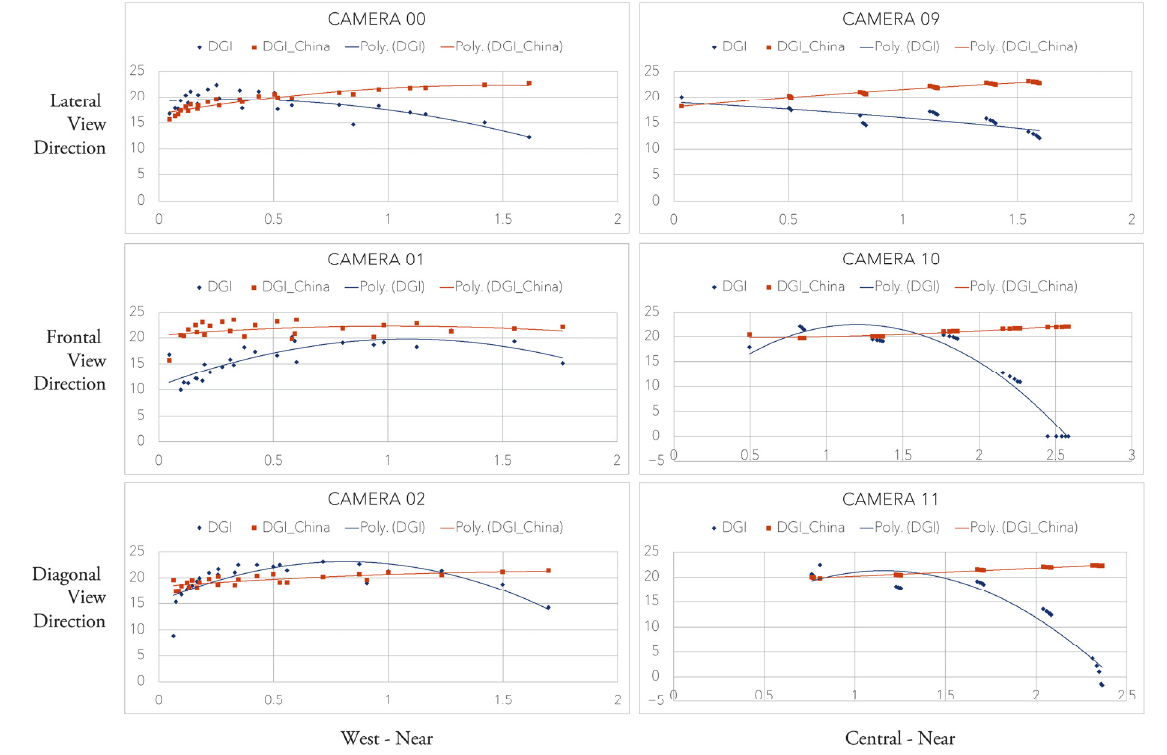
Figure 8. Comparative study on camera viewing location near the window with solid angles ( X -axis) against DGI and DGI China evaluation ( Y -axis).